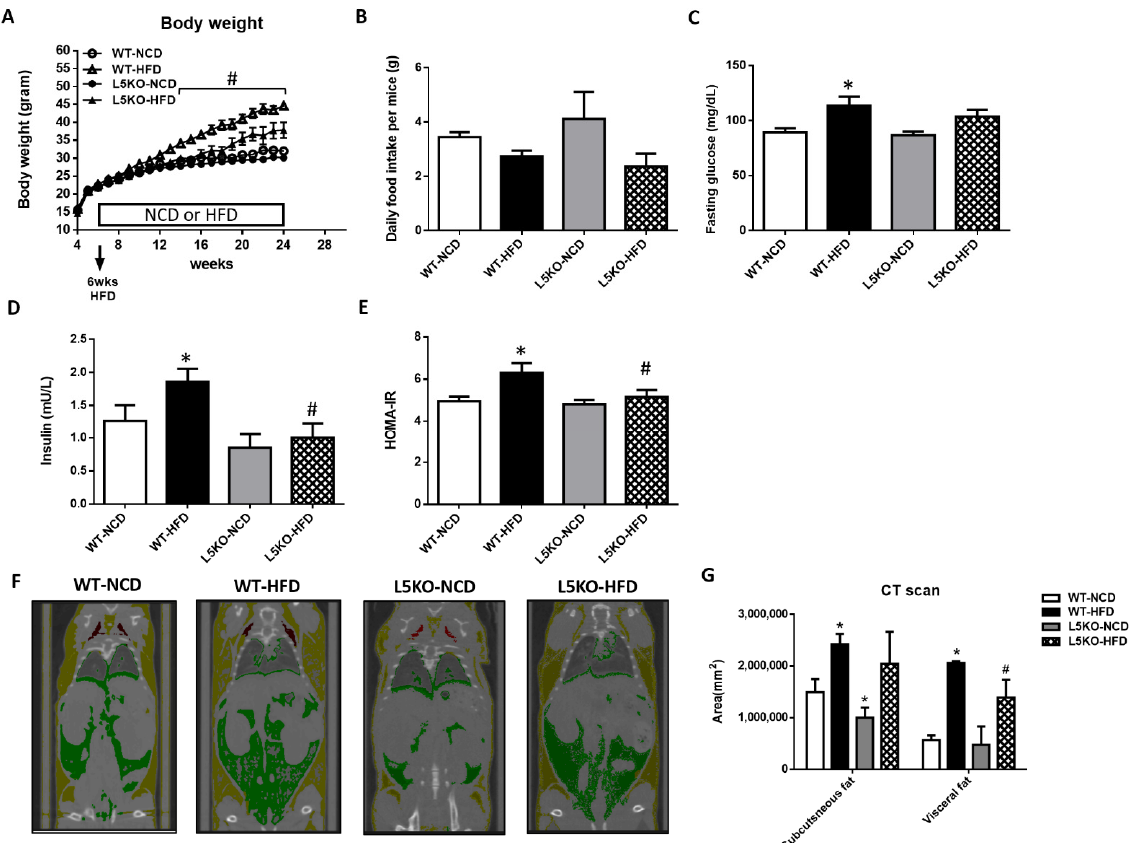
Figure 1. Protection against HFD-induced obesity in CCL5 knockout (CCL5KO) mice. WT and CCL5KO mice were fed high fat diet (HFD) or normal chow diet (NCD) ( n = 9–12 per group)